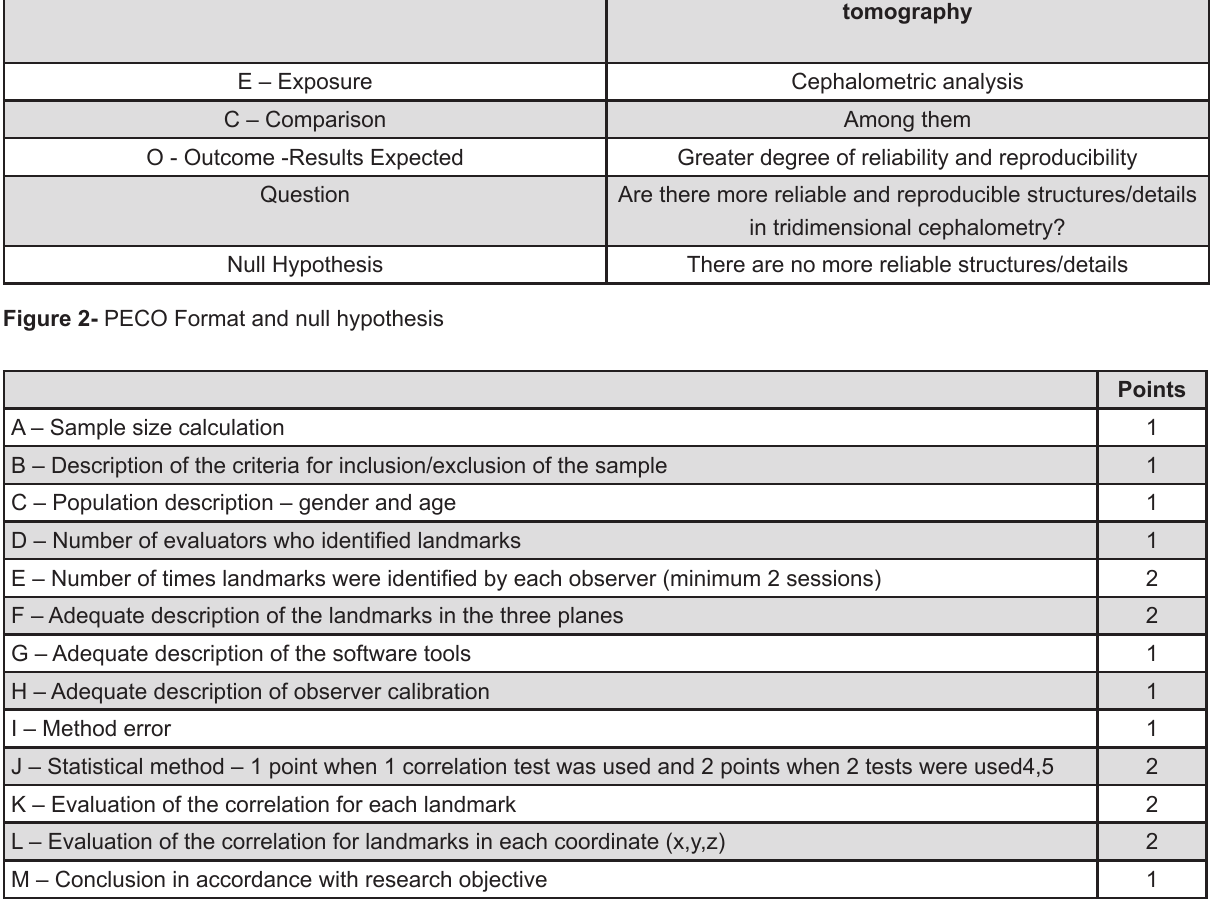
Figure 3- Methodological quality scoring protocol (maximum score: 18